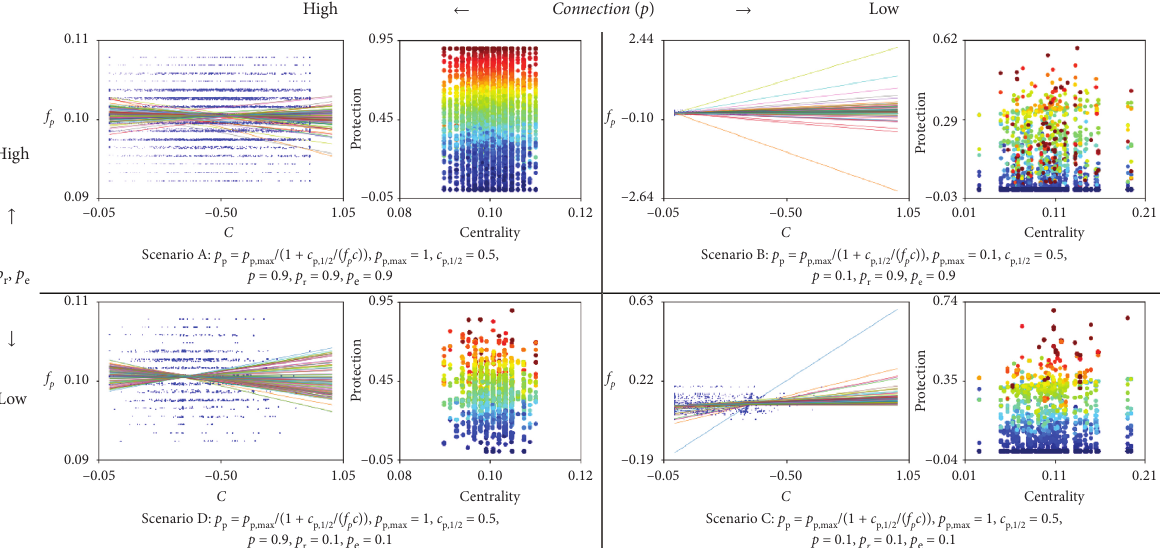
Figure 4: Protection dynamics against systemic risk with pattern recognition. At each section, the plot of the left-hand side shows the ) and the eigenvector centrality ( C ) which is controlled by the initialized random network property relation between protection level ( f p ( G ( n, p ) ⟶ C � eigenvector centrality) according to time steps (100). The blue dots represent individuals, and the lines represent re- gressions at each time step. The plots of the right-hand side at each section represent that large connection probability caused asymmetric pattern with the correlation between the two parameters. Instead, the small connection probability does